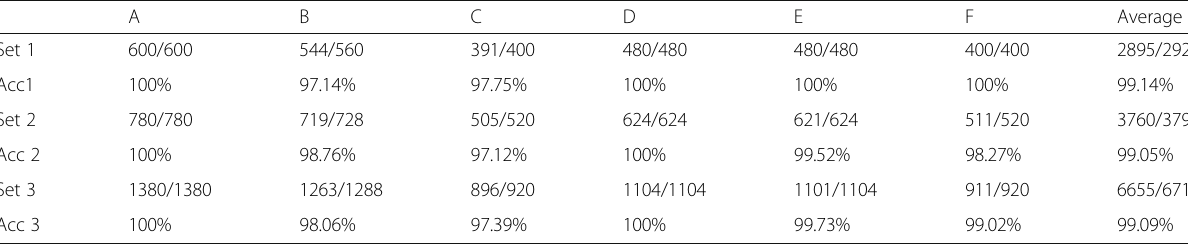
Table 4 Accuracy of human posture